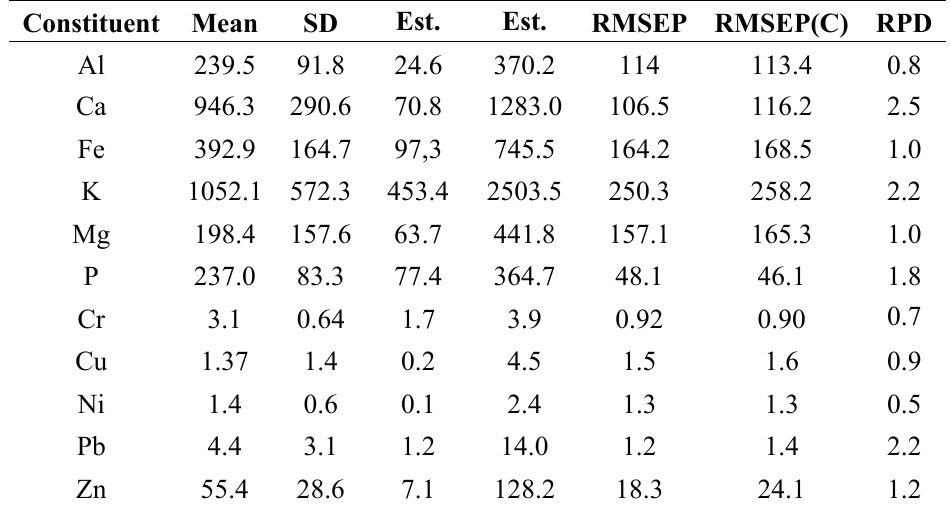
Table 4. External validation of minerals in propolis by NIR (number of samples: